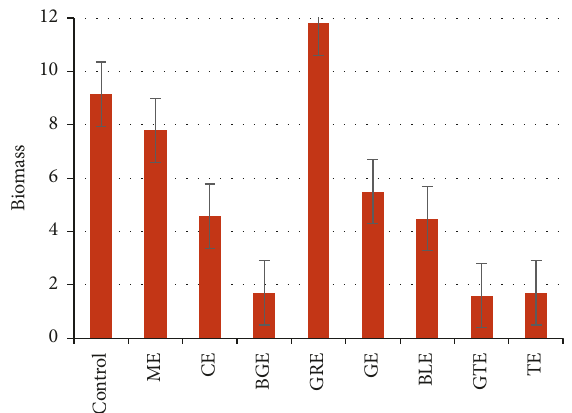
Figure 1: Effects of biocides on the growth of SRB bacteria, on the 7 th day of cultivation.